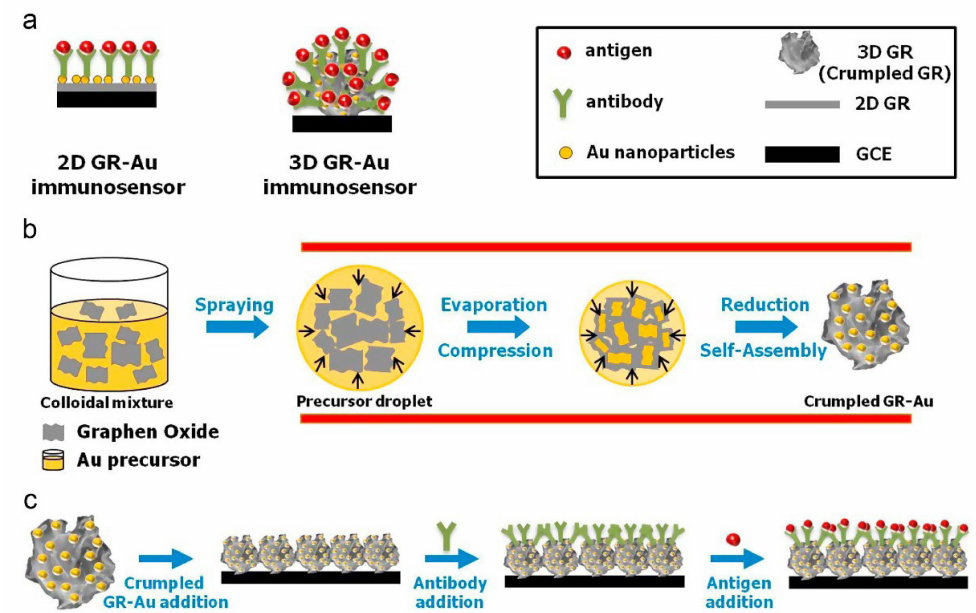
Figure 20. ( a ) Schematic representation of electrodes containing 2D GR–Au and 3D GR–Au, ( b ) prepa- ration of wrinkled GR–Au composites using aerosol spray pyrolysis method, and ( c ) immunosensor surface modification with related composite materials and biomolecules. Reprinted with permission from Ref. [127]. Copyright 2015,